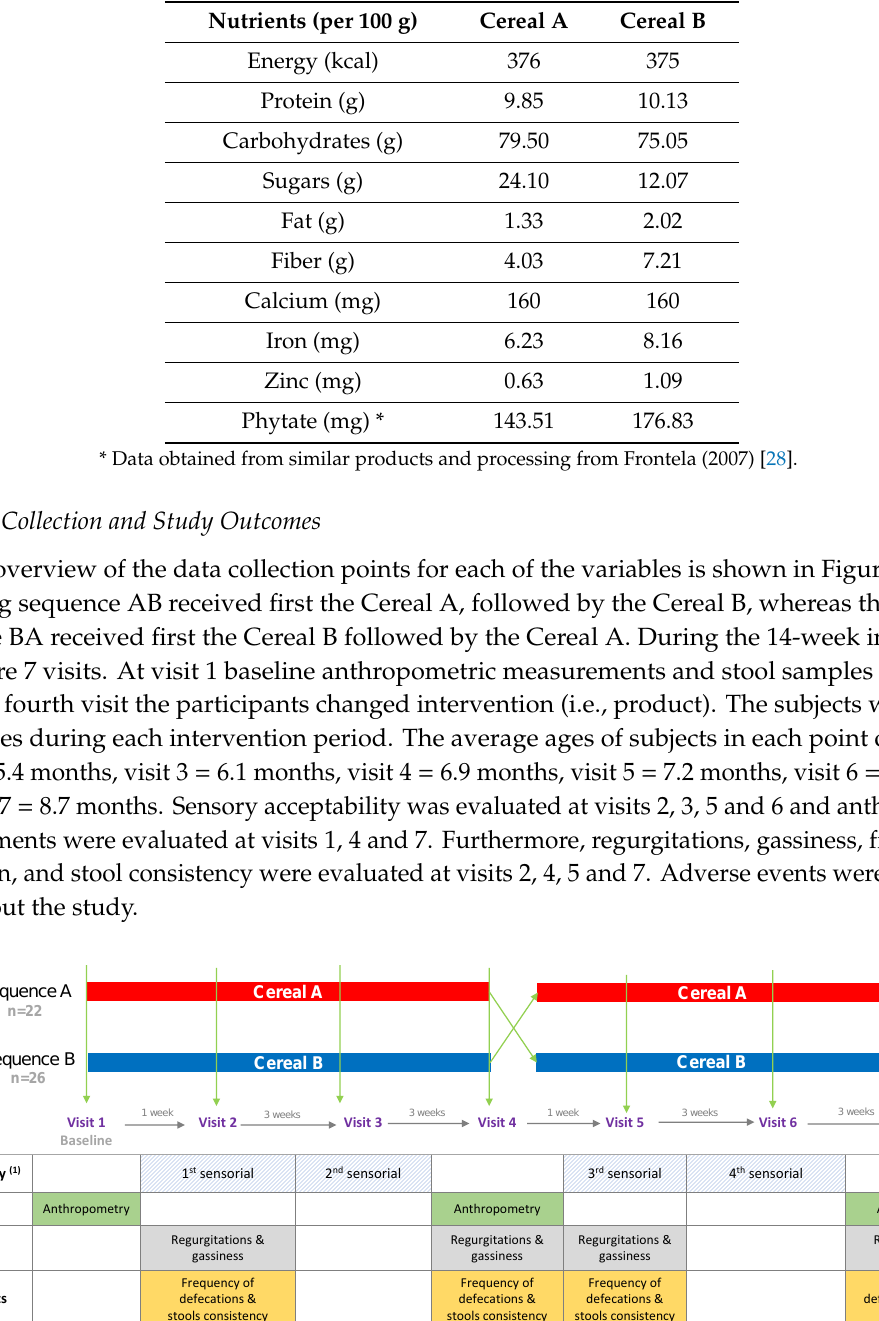
Table 1. Nutritional composition of the two infant cereals used in the study (Cereal A—0% whole grains and 24 g / 100 g sugars and Cereal B—50% whole grains and 12 g / 100 g sugars).